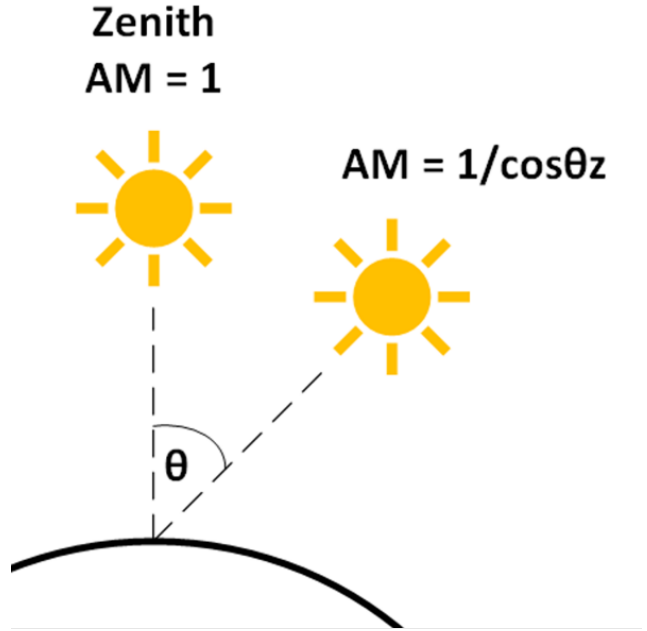
Figure 1. Explanation of air mass notion.